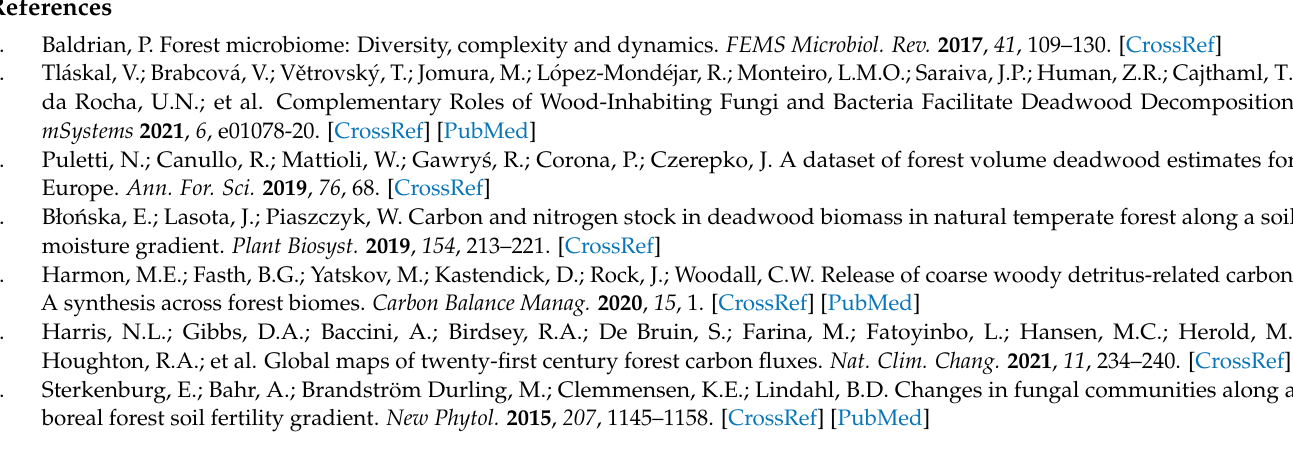
Table S2: Dominant fungal taxa found in the coarse woody debris of Abies alba and Fagus sylvatica from the Salajka natural